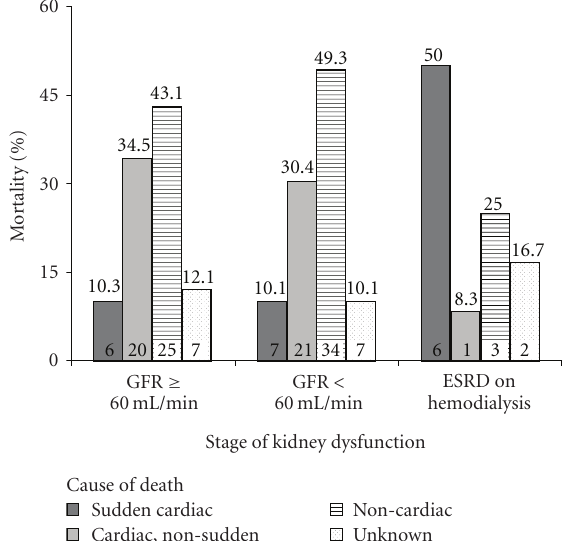
Figure 2: Cause-specific mortality according to varying levels of renal dysfunction. For the 3 categories of renal dysfunction, cause- specific mortality is depicted. As expected, sudden cardiac death was the major cause of death in ESRD patients on dialysis (50.0% versus 10.1% (GFR < 60 mL/min) versus 10.3% (GFR ≥ 60mL/min), Chi Square P = . 010). Number at the top of each bar is the mortality rate; number within the bar is the n per group. The Unknown category was reserved for those patients whose cause of death could not be determined. Thus, adding the numbers within the bars for three groups will not equal the n given in Table